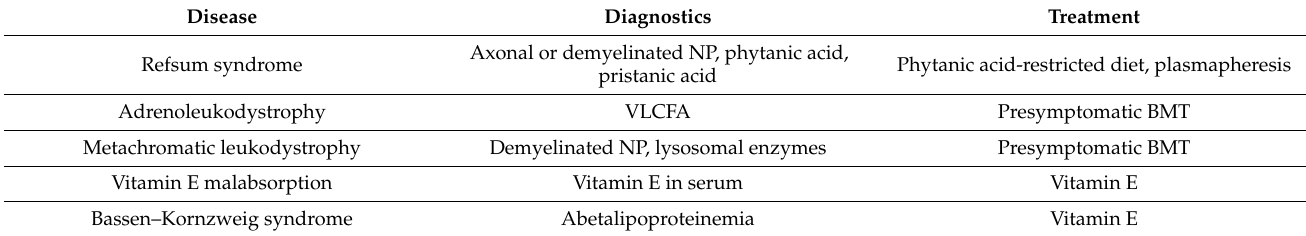
Table 6. Neuropathies in the context of complex hereditary diseases amenable to treatment [11].